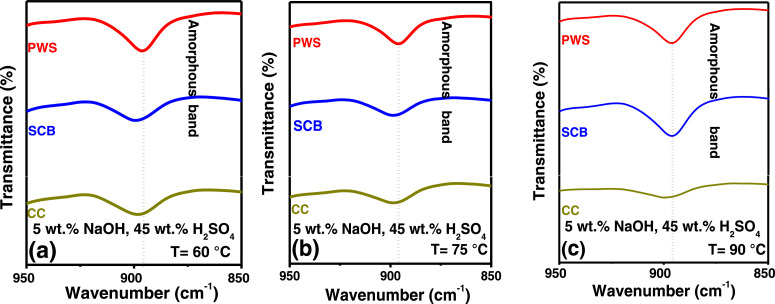
FTIR spectra of crystalline nanocellulose from CC, SCB and PWS produced with 5 wt.% NaOH, 45 wt.% H2SO4 at (a) 60°C, (b) 75°C and (c) 90°C.